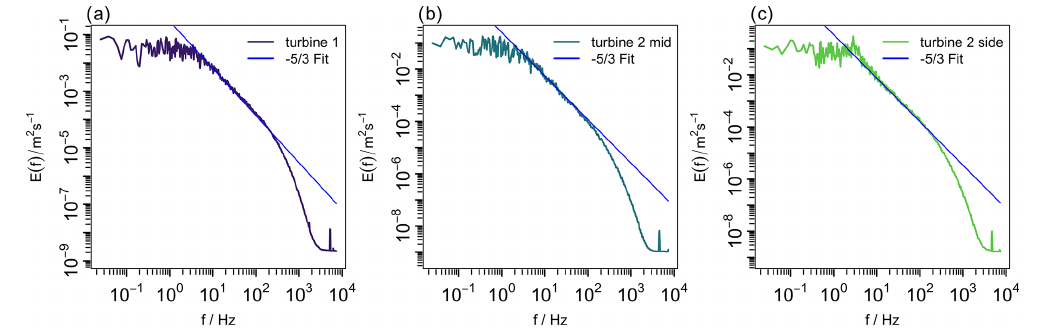
Figure 4. Energy spectral density E ( f ) over frequency f at the maximum turbulence intensity ( X/D = 6 . 24 for turbine 1, X/D = 1 . 79 for turbine 2 mid, and X/D = 2 . 45 for turbine 2 side) for the three different inflow conditions: (a) turbine 1 – laminar inflow, (b) turbine 2 mid – turbulent, and (c) turbine 2 side – turbulent and intermittent. In blue, the E ( f ) ∝ f − 5 / 3 decay is marked.